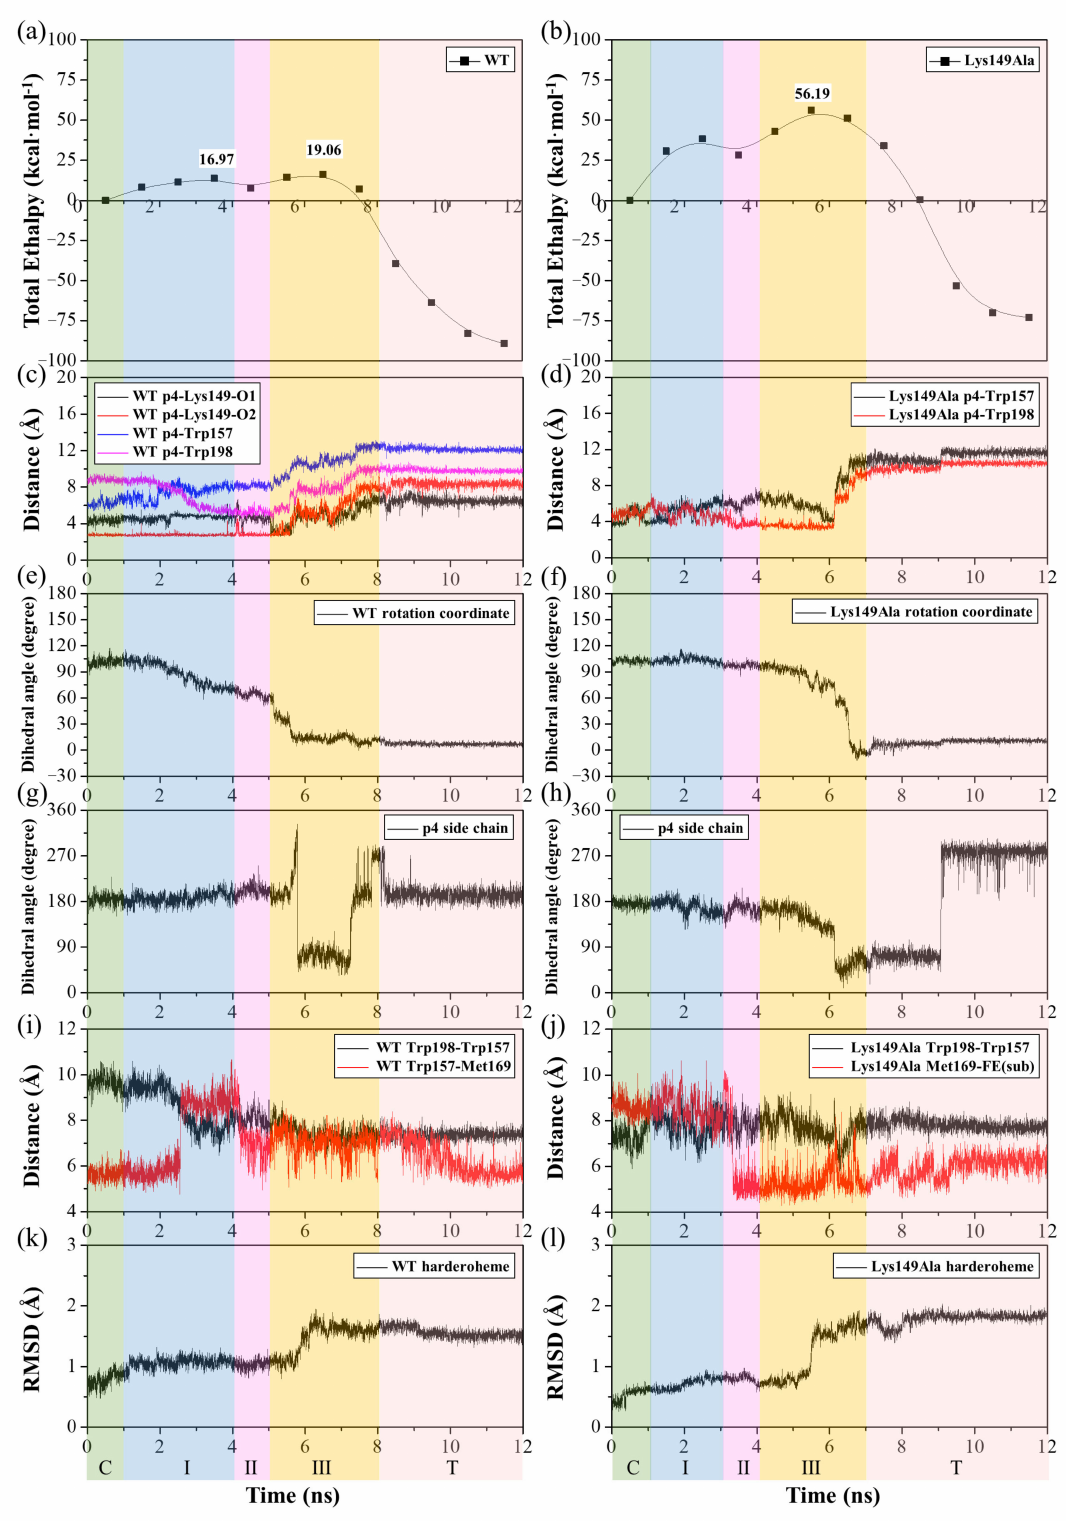
Figure 6. The time-dependent evolution of the harderoheme clockwise rotation of WT and the Lys149Ala mutant. ( a , b ) MM-PBSA enthalpy diagram of WT and Lys149Ala, respectively. ( c ) Dis- tances between ammonium N of Lys149 and each of the two carboxylate O of p4 of WT in black and red, respectively, and distances between the C δ of p4 and the mass centers of two hydrophobic residues Trp157 and Trp198 in blue and magenta, respectively. ( d ) Distances between the C δ of p4